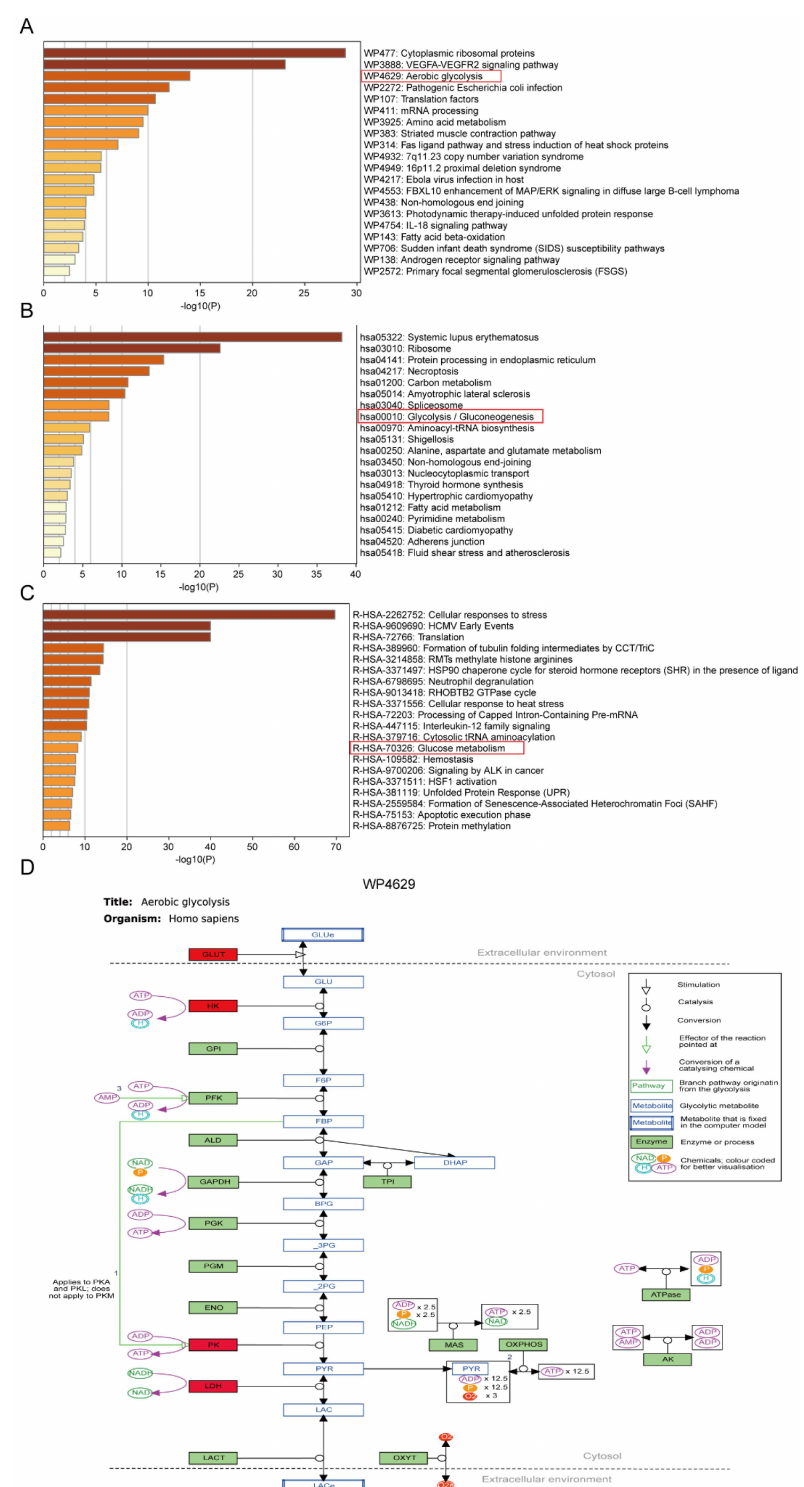
Figure 2. FA + p-CA are involved in the aerobic glycolysis pathway. The FA and p-CA target proteins were imported into the Metascape database for gene enrichment analysis. ( A – C ) Summary of enrichment analysis in WikiPathways ( A ), KEGG ( B ) and reactome pathway knowledgebase ( C ), colored by p -values, the color becomes lighter as the p -value increases. The red box shows that genes are enriched in the glycolytic pathway. ( D ) Aerobic glycolysis (WP4629) pathway involving FA and p-CA target